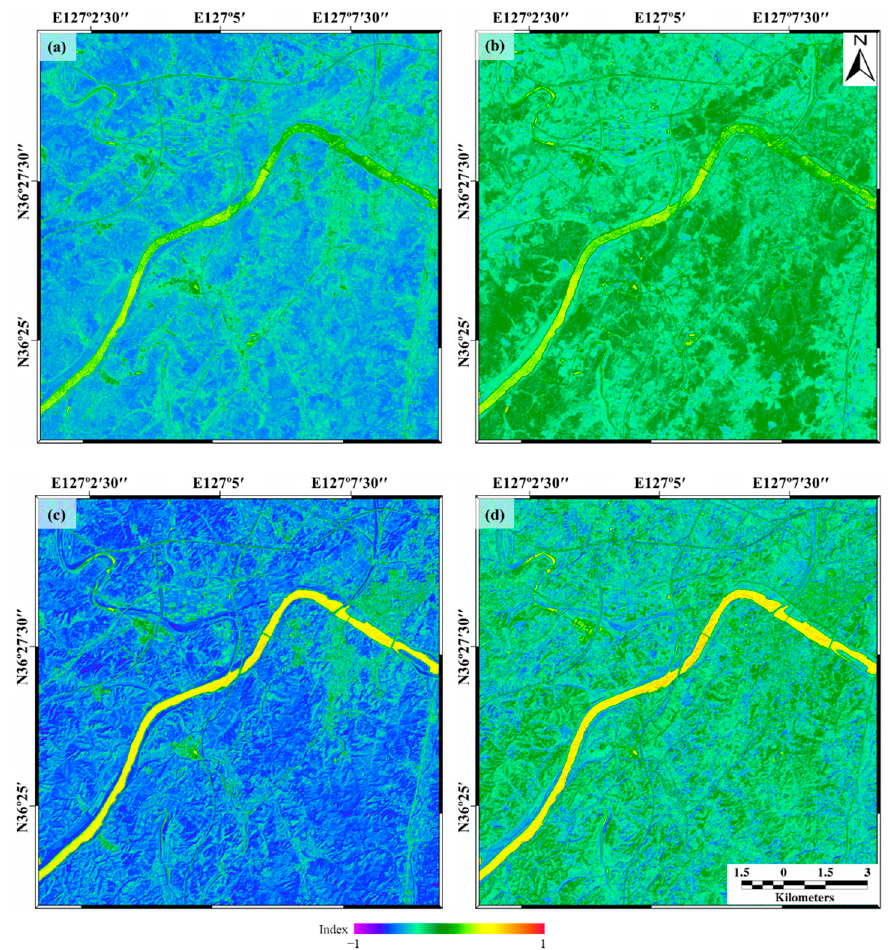
Figure 7. Input neurons of NDWI1 and NDWI2 created from Sentinel-2 image: ( a ) NDWI1 in spring and ( b ) fall season, ( c ) NDWI2 in spring and ( d ) fall season.